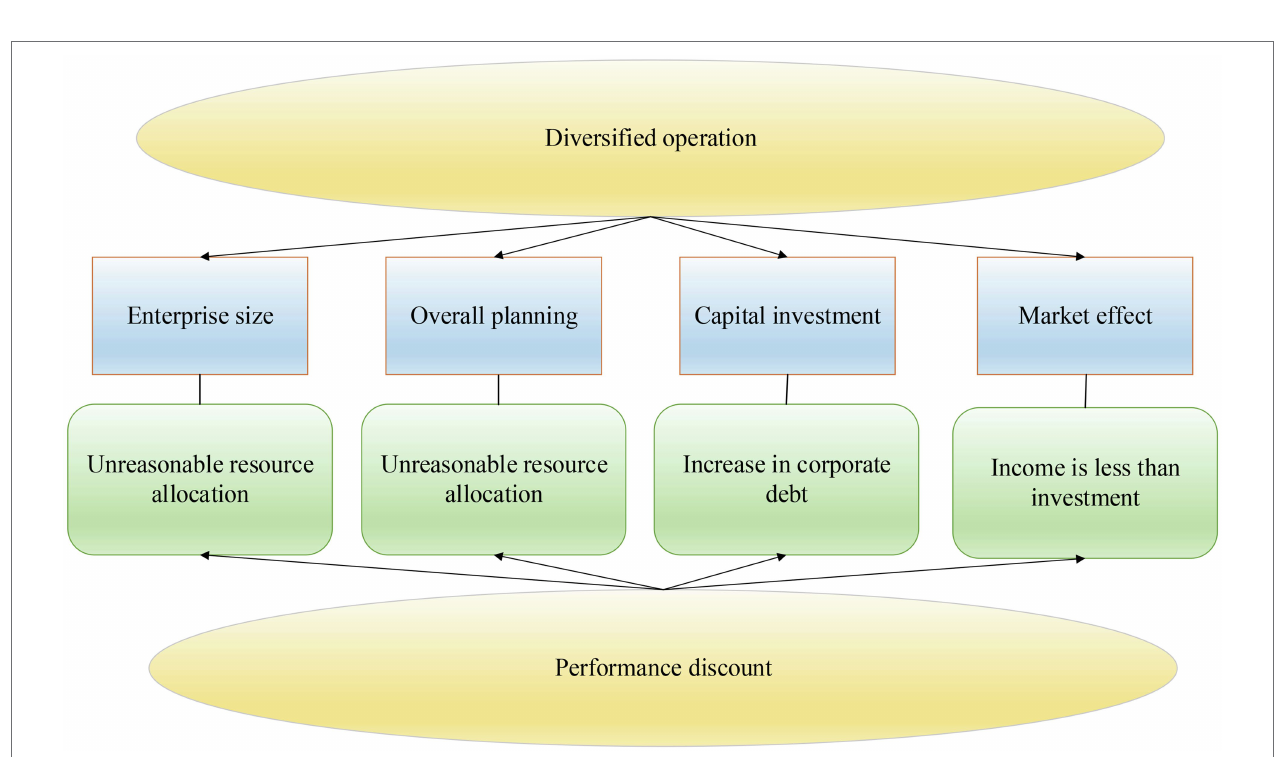
FIGURE 6 | The negative effects of